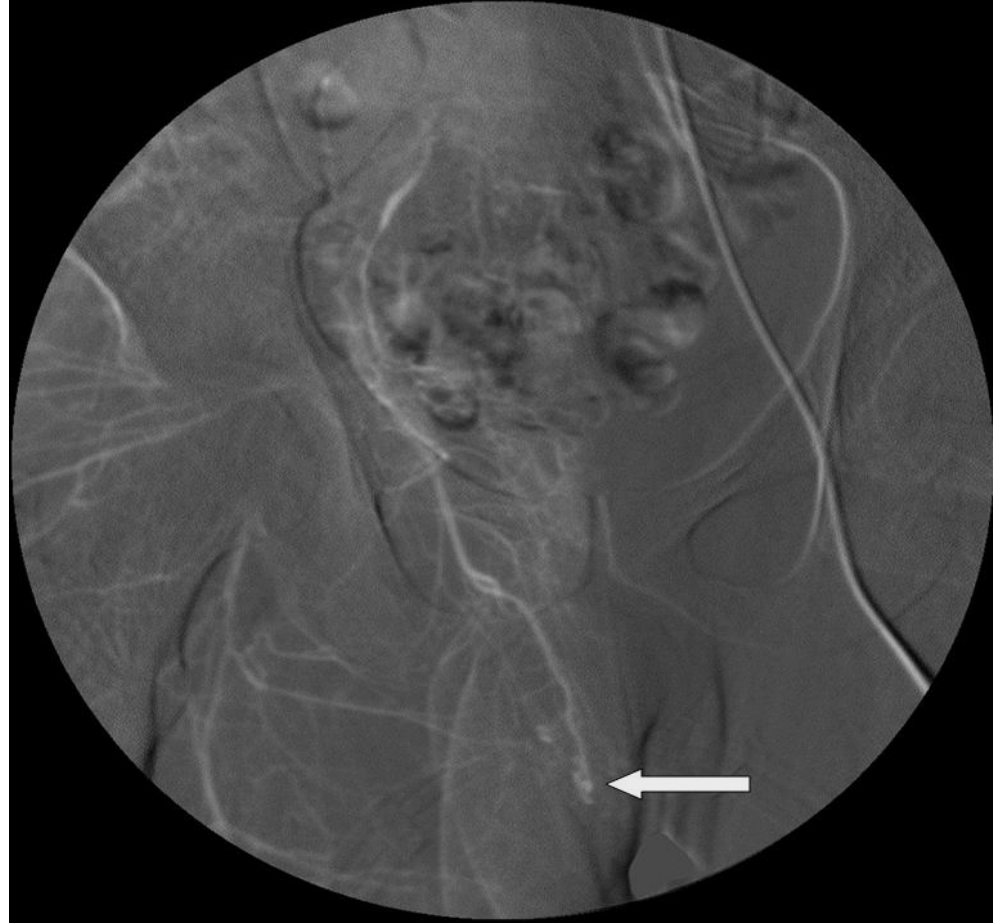
FIGURE 3. Pre-embolization subtraction arteriogram of the right iliac and pudendal arteries via left transfemoral approach showing an evidence of small-cavity-filled contrast (arrow) related to the right cavernosal artery.